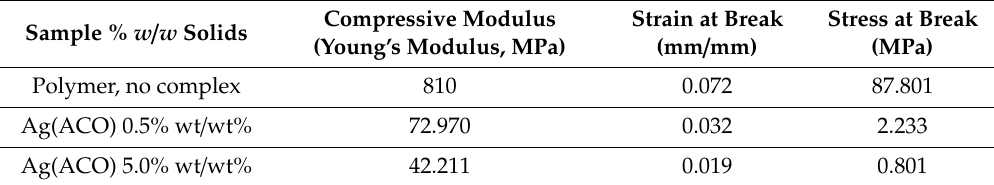
Table 1. Summary of mechanical testing of studied polymeric composites with embedded silver(I) cyanoximates.